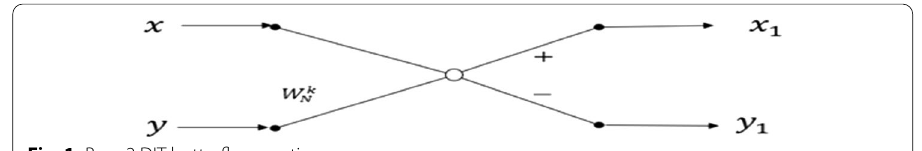
Fig. 1 Base 2 DIT butterfly operation